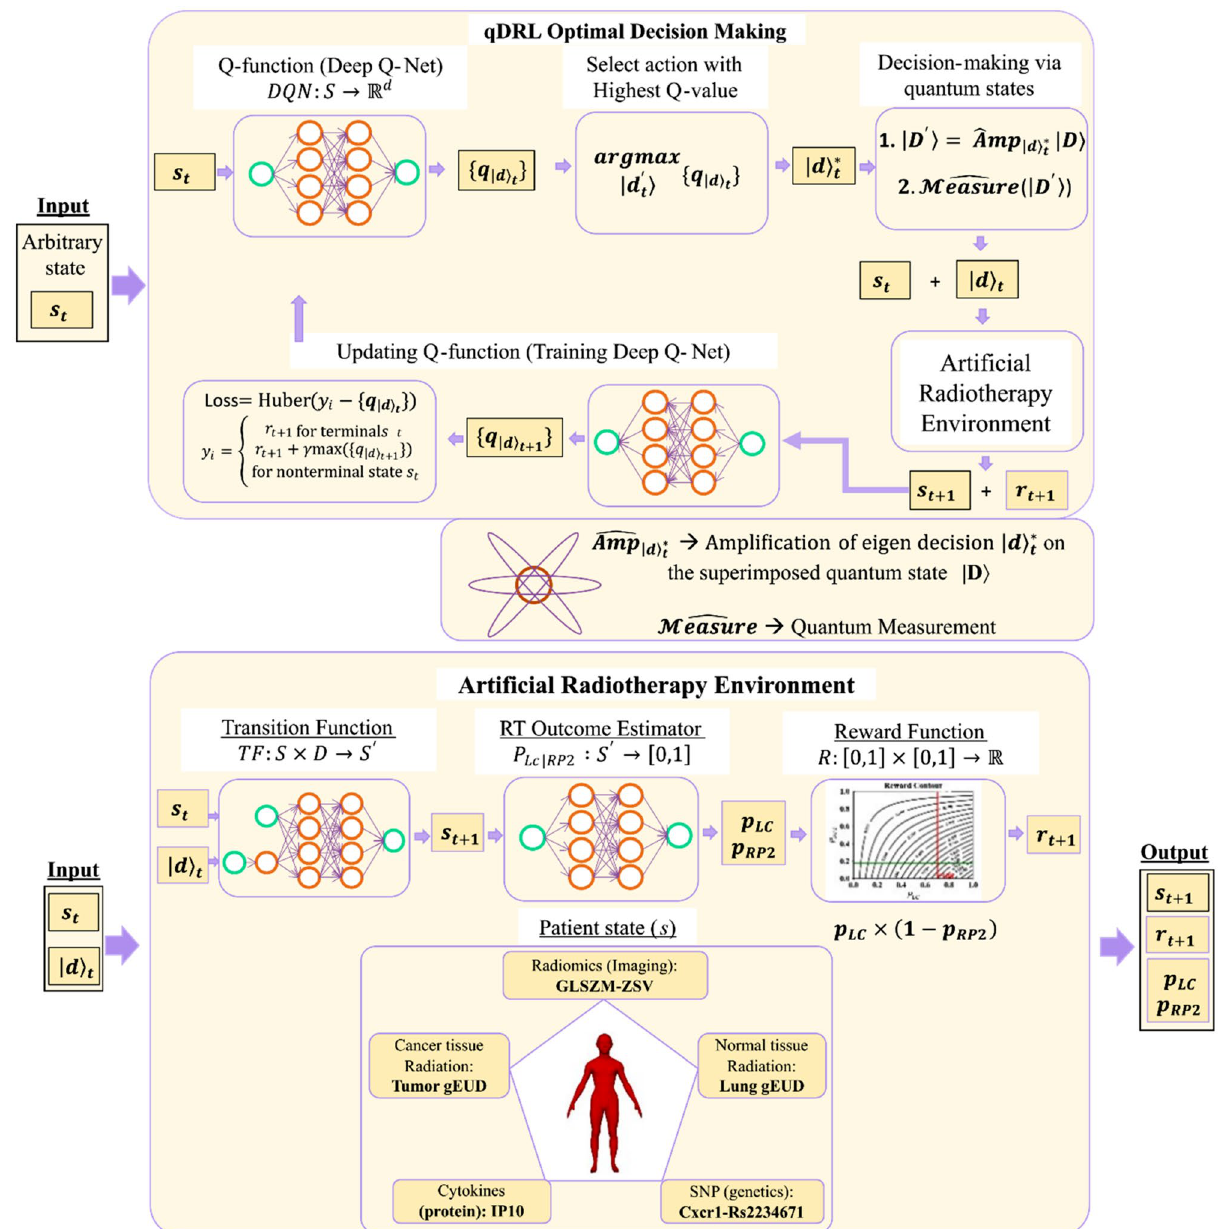
Figure 2. Quantum deep reinforcement learning algorithm for optimal decision making in knowledge- based adaptive radiotherapy. Schematic of a quantum deep reinforcement learning (qDRL) algorithm for optimal decision making in knowledge-based adaptive radiotherapy. qDRL employs deep q-net as a decision optimization algorithm and employs quantum state as the decision. Here, qDRL is a model-based algorithm that utilizes an artificial radiotherapy environment (ARTE) as the RL model. The qDRL artificially intelligent (AI) agent feeds in patient’s state s t in its memory (deep q-net) and obtains a set of q-values for a range of (cid:30) ) . The agent then selects the dose with the highest q-value and performs quantum amplification dose ( (cid:31) q | d � t of that dose on a superimposed quantum dose decision state, | D � . A quantum measurement is performed on the amplified state. The obtained dose measurement, | d � t , along with the state s t is fed into the ARTE. ARTE is composed of three functions in succession: (1) transition function, (2) RT outcome estimator, and (3) reward function, which predicts the patient’s next state s t + 1 , RT treatment outcome in terms of probability of local control, p LC , and probability of radiation induced pneumonitis of grade 2 or higher, p RP 2 , and reward value, r t + 1 , for the state-dose-decision pair. s t + 1 , and r t + 1 are then used by the quantum agent to update its memory. This cycle is repeated until the agent finds a terminating state, after which a new cycle is initiated for a different patient. Five relevant biophysical features from radiomics, cancer and normal tissue radiation, cytokines, and genetics, were selected to represent the patient’s state based on our earlier work 13